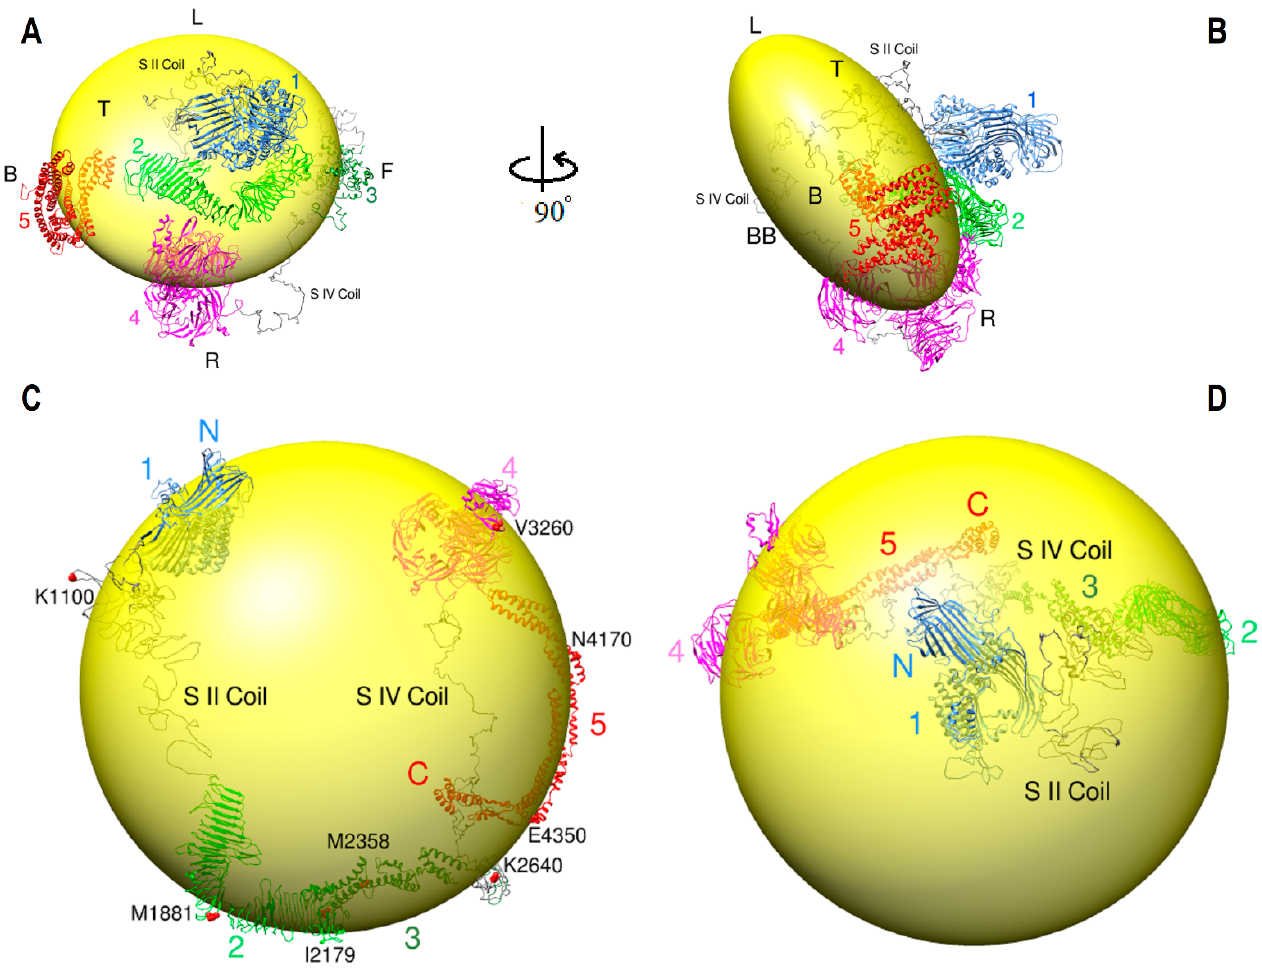
Figure 8. ApoB-100 architecture on lipoprotein particles. ( A , B ) Ribbon representation of apoB-100 on discoidal LDL (20 nm × 20 nm × 11 nm). The LDL particle is round from the top (Figure A) and oval shape from the side views (Figure B). Segments one (1) and two (2) are located on the top (T) of the disc. Subunit II coil (S II coil) is folded and positioned beneath subunit I. Segment three (3) on the front (F), segment four (4) on the bottom (BB) and right (R), and segment five (5) are located on the back (B). The protein does not cover the LDL particle’s left (L) side. ( C , D ) Ribbon representation of apoB-100 on spherical VLDL with 30 nm diameter. The structure encircles the lipid particle starting from the N-terminus (N) through segment four (4), then moves in the opposite direction (5) and crosses segment four and ends at the C-terminus (C). The red spherical representation of residue M1881 indicates the kink start point through M2358. Part of the protein from the N-terminus to I2179 illustrates apoB-48.